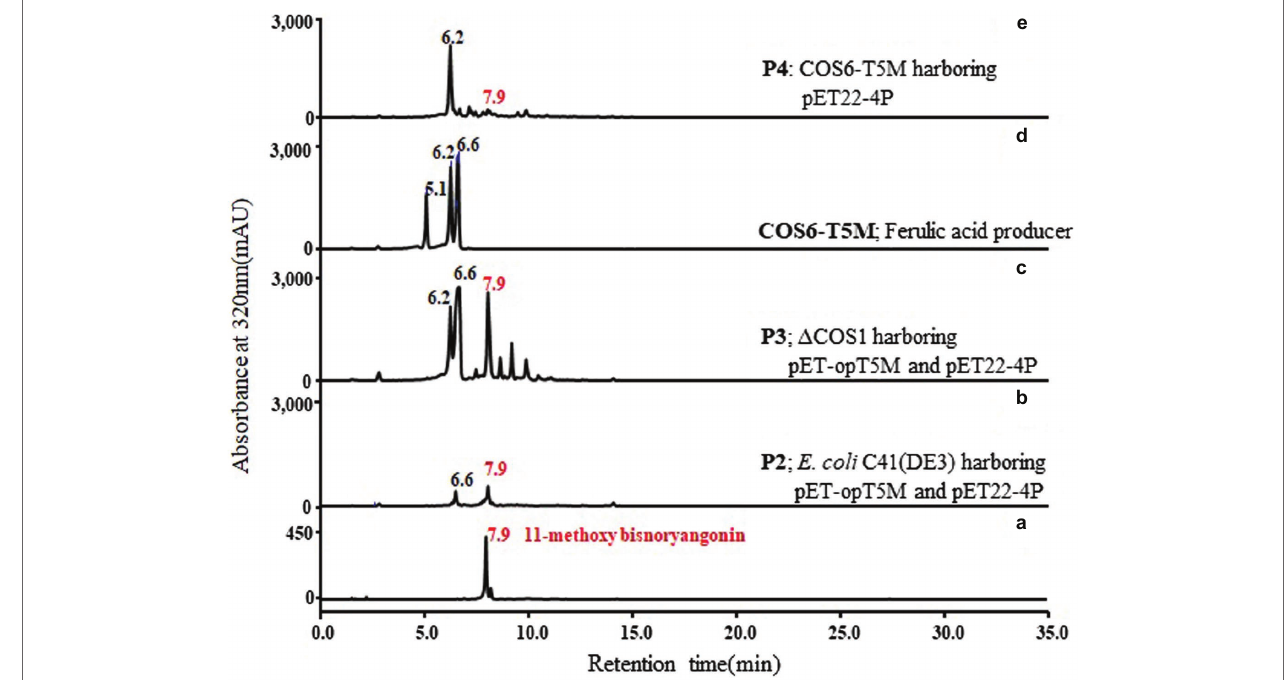
FIGURE 6 | De novo biosynthesis of 11-methoxy-bisnoryangonin by the P2, P3, and P4 strains. Comparison of HPLC profiles of purified 11-methoxy- bisnoryangonin (a); the culture broth of P2 ( E. coli C41 strain harboring pET-opT5M and pET22-4P), (b); P3 ( ∆ COS1 strain harboring pET-opT5M and pET22-4P), (c); COS6-T5M (d); and P4 (COS6-T5M strain harboring pET22-4P), (e). The peaks correspond to caffeic acid (5.1 min), 4-coumaric acid (6.2 min), ferulic acid (6.6 min), and 11-methoxy-bisnoryangonin (7.9